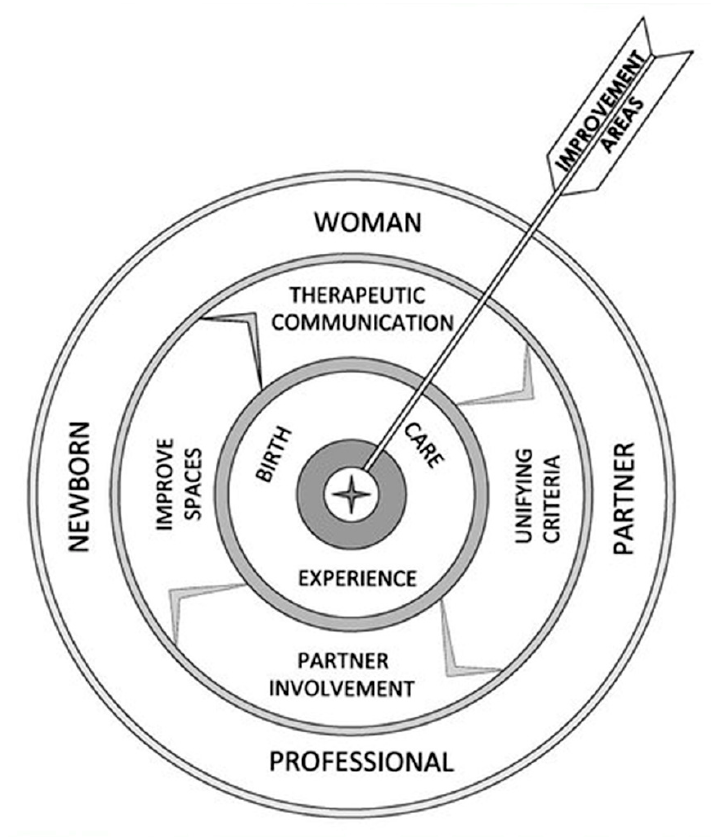
Figure 2. Representation of the areas for improvement raised by the participants. lowing: (a) strengthening communication and the therapeutic relationship; (b) unifying